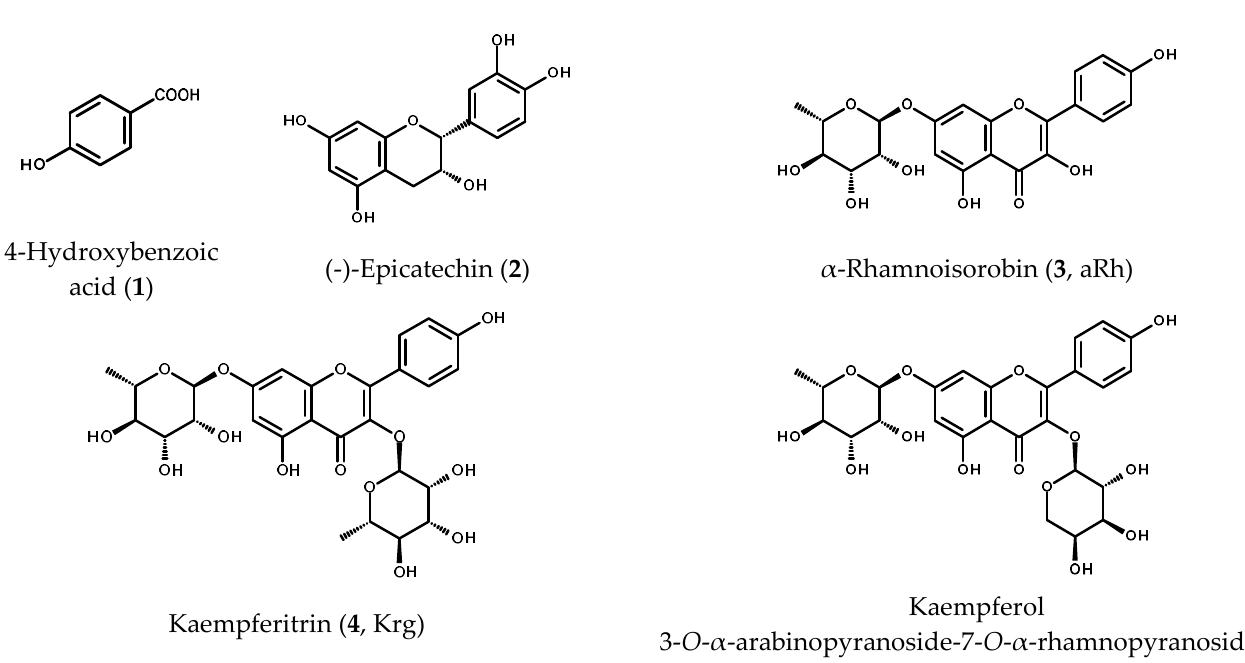
Figure 1. Chemical structures of phenolics 1 – 5 from the leaves of Maesa membranacea. 2.2. The Impact of the Tested Flavonols on Cell Proliferation and Biosafety Issues Under the cell proliferation favoring conditions (culture medium with 10% FBS), we did not notice any impact of Krg or isoquercitrin (IQ) given in wide range of concentrations (5–50 µ M), for 48 and 72 h, on the undifferentiated UN-SH-SY5Y cell proliferation rate (Figure 2b,c). However, aRh at concentrations of 10 and 50 µ M in a time- and concentration- dependent manner reduced cell proliferation in UN-SH-SY5Y cells by about 28% for 50 µ M of aRh after 48 h, and by 30% and 50% after 72 h for 10 and 50 µ M aRh, respectively (Figure 2a). After 24 h treatment of UN-SH-SY5Y or retinoic acid-differentiated RA-SH- SY5Y cells with the highest tested concentration of Krg or aRh (50 µ M each), we did not find any significant changes in the cell viability when compared to the vehicle-treated cells (Figure 3a,b). aRh at concentrations of 50 µ M slightly reduced UN-SH-SY5Y cell viability (Figure 3a), and this effect was less pronounced in RA-SH-SY5Y cells (Figure 3b). 2.3. The Impact of the Vehicle on the Cell Damage Induced by Various Factors in UN- and RA-SH-SY5Y Cells The solvent used to solubilize the flavonols (70% ethanol) when given alone to cell cultures (final concentration 0.7%) for 24 h did not affect the cell viability of UN- or RA-SH- SY5Y cells (data not shown). However, the presence of ethanol exaggerated the cell damage induced by H 2 O 2 and 6-OHDA in UN- and RA-SH-SY5Y cells (Figure 4a,b). Interestingly, 0.7% ethanol did not change the extent of cell damage induced by the pro-apoptotic factor doxorubicin (Dox) (Figure 4c). Moreover, we confirmed the previous findings that the cell damage induced by H 2 O 2 or 6-OHDA in SH-SY5Y cells is oxidative stress- dependent [24,25] since the co-treatment with antioxidant (NAC) completely prevented the cell death evoked by these factors (Figure